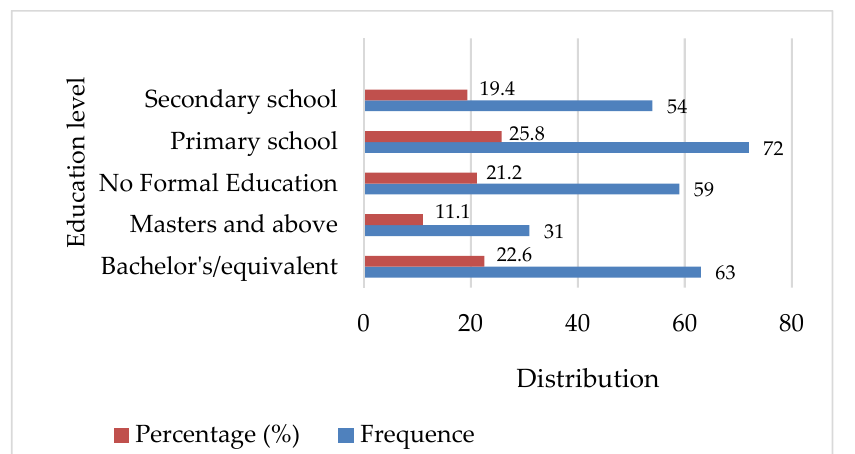
Figure 2. Household’s educational background.